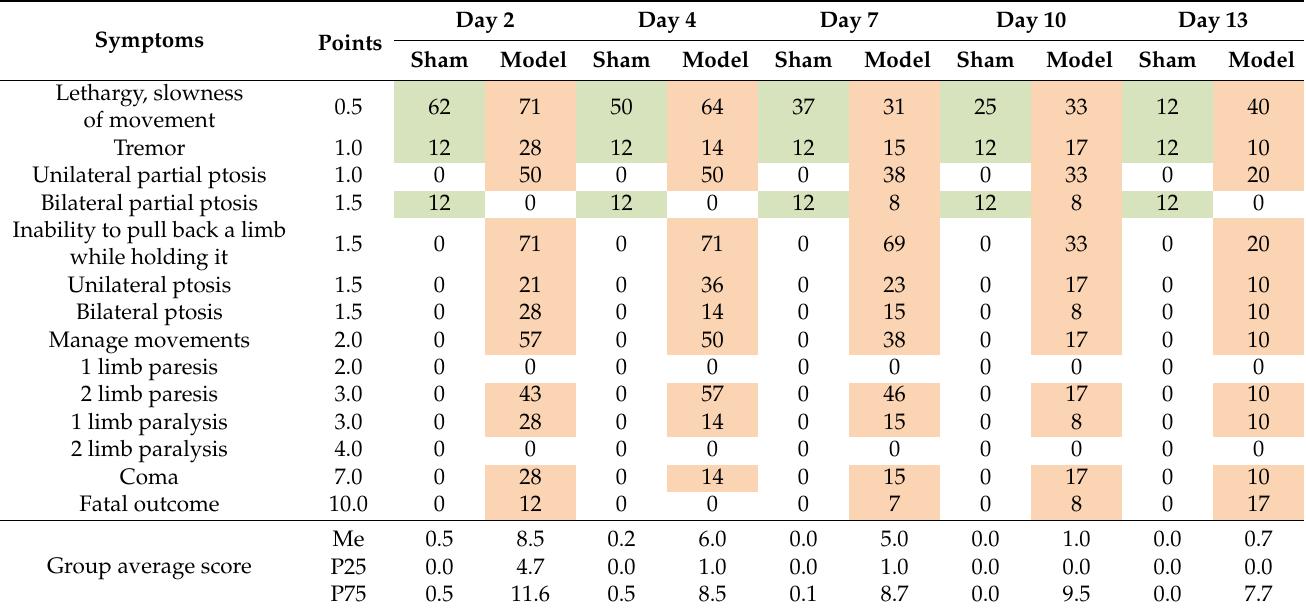
Table 3. Results of the assessment of neurological deficit according to [26]. In the table, colored cells give the percentage of animals with recorded symptoms. Group average score presented as Me, (P25–P75).